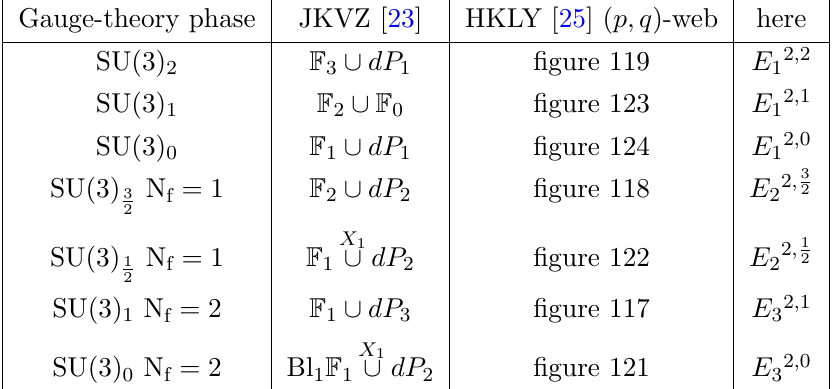
P 1 , dP n ) (cid:12)bration of P 1 n denotes the (cid:0) (cid:2)